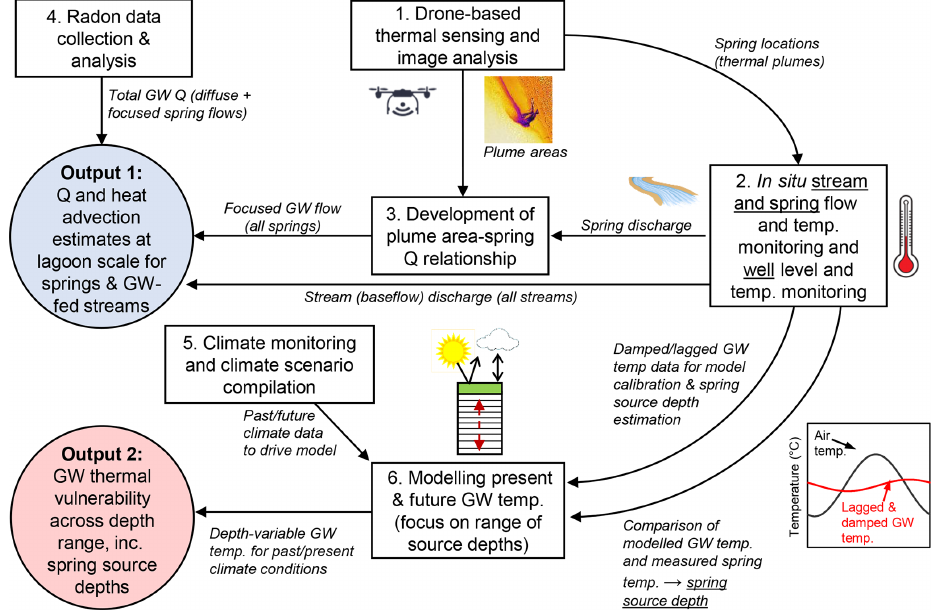
Figure 2. Diagram showing how the different aspects of this study are interrelated. Boxes indicate key study methods/elements, circles indicate key study outputs, and arrows and italicized text indicate outputs from one study element that become inputs for another. Q is discharge; GW is